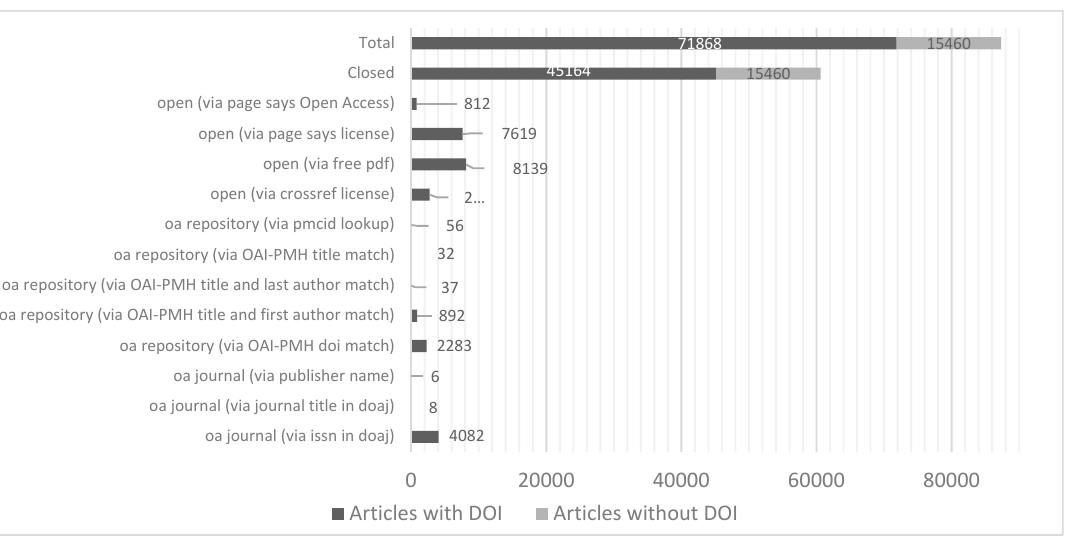
Figure 1. Open and closed articles according to oaDOI Best_location, 2011–2016.